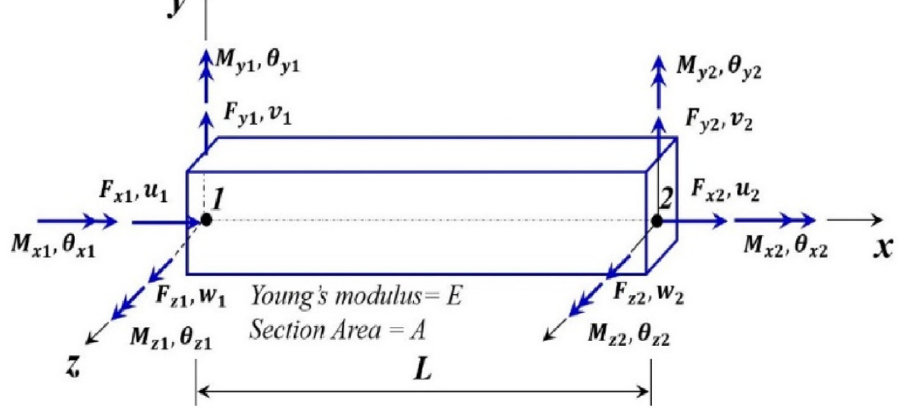
Figure 5. 12-DOF beam element in MSA method [87].